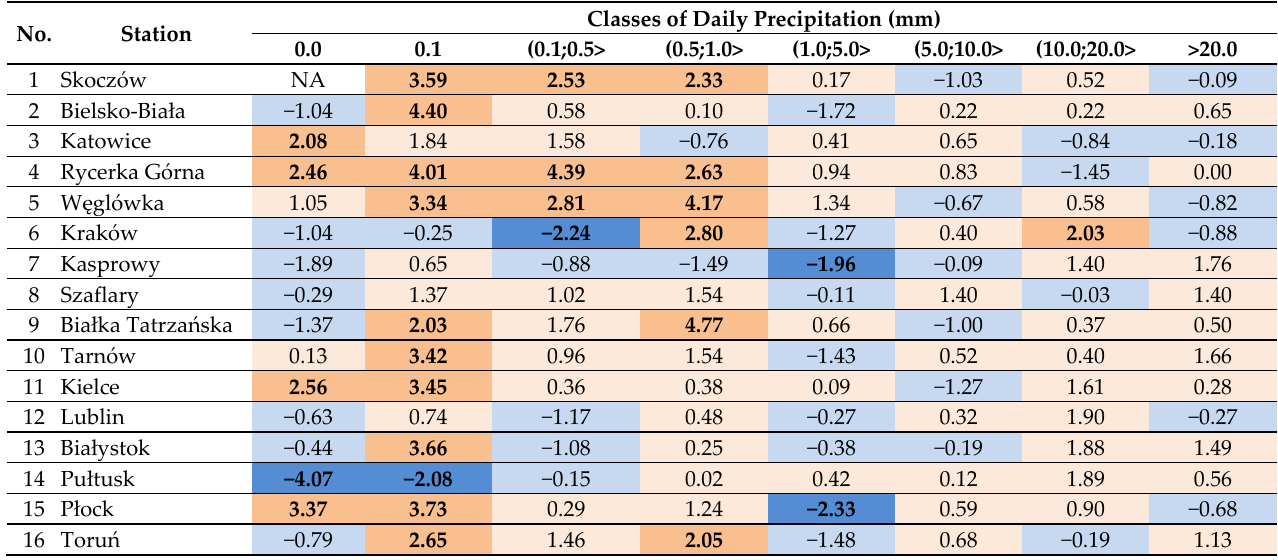
Table 13. Results of the Mann test ( uF statistics) for trends in precipitation structure in the summer season; orange colour denotes positive uF values, blue colour negative. Numbers in bold indicate statistically significant changes at α level 0.05.